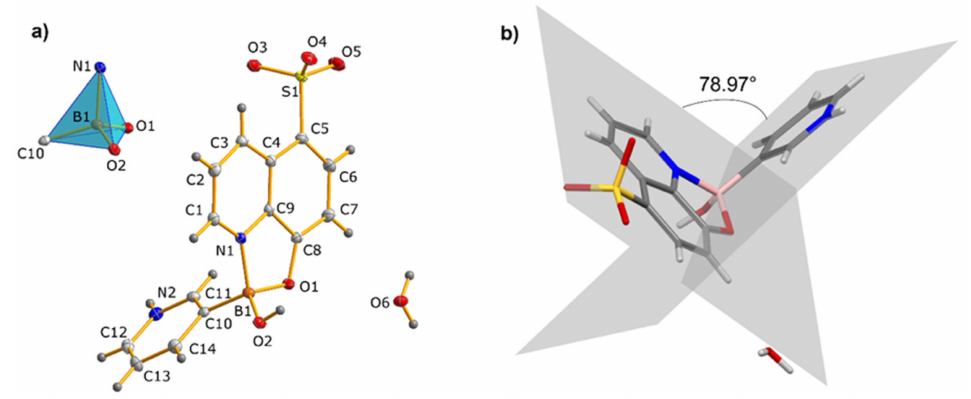
Figure 1. ( a ) Perspective view of the asymmetric unit of compound 1 with atom labeling and ellipsoids drawn at the 50% probability level. Selected bond parameters: B1-N1 = 1.6422(19), B1-O1 = 1.5176(18). B1- O2=1.4121(18), B1-C10=1.614(2)Å,O1-B1-N1=98.25(10), O1-B1-C10 = 109.84(11), O2-B1-O1 = 114.71(12), O2-B1-N1 = 111.63(11), O2-B1-C10 = 110.87(12), C10-B1-N1 = 110.94(11) ◦ . ( b ) Angle between the quinoline and pyridinium rings in 1 .